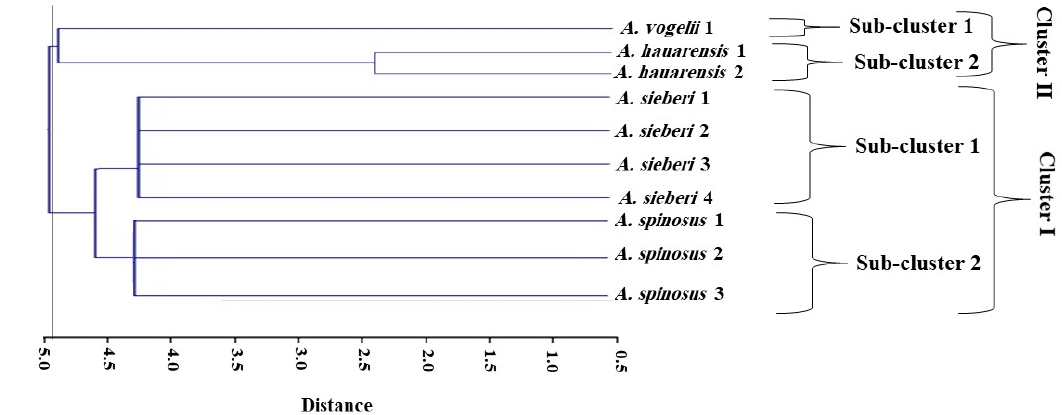
Figure 2. Agarose gel electrophoresis showing DNA extraction for 10 samples.